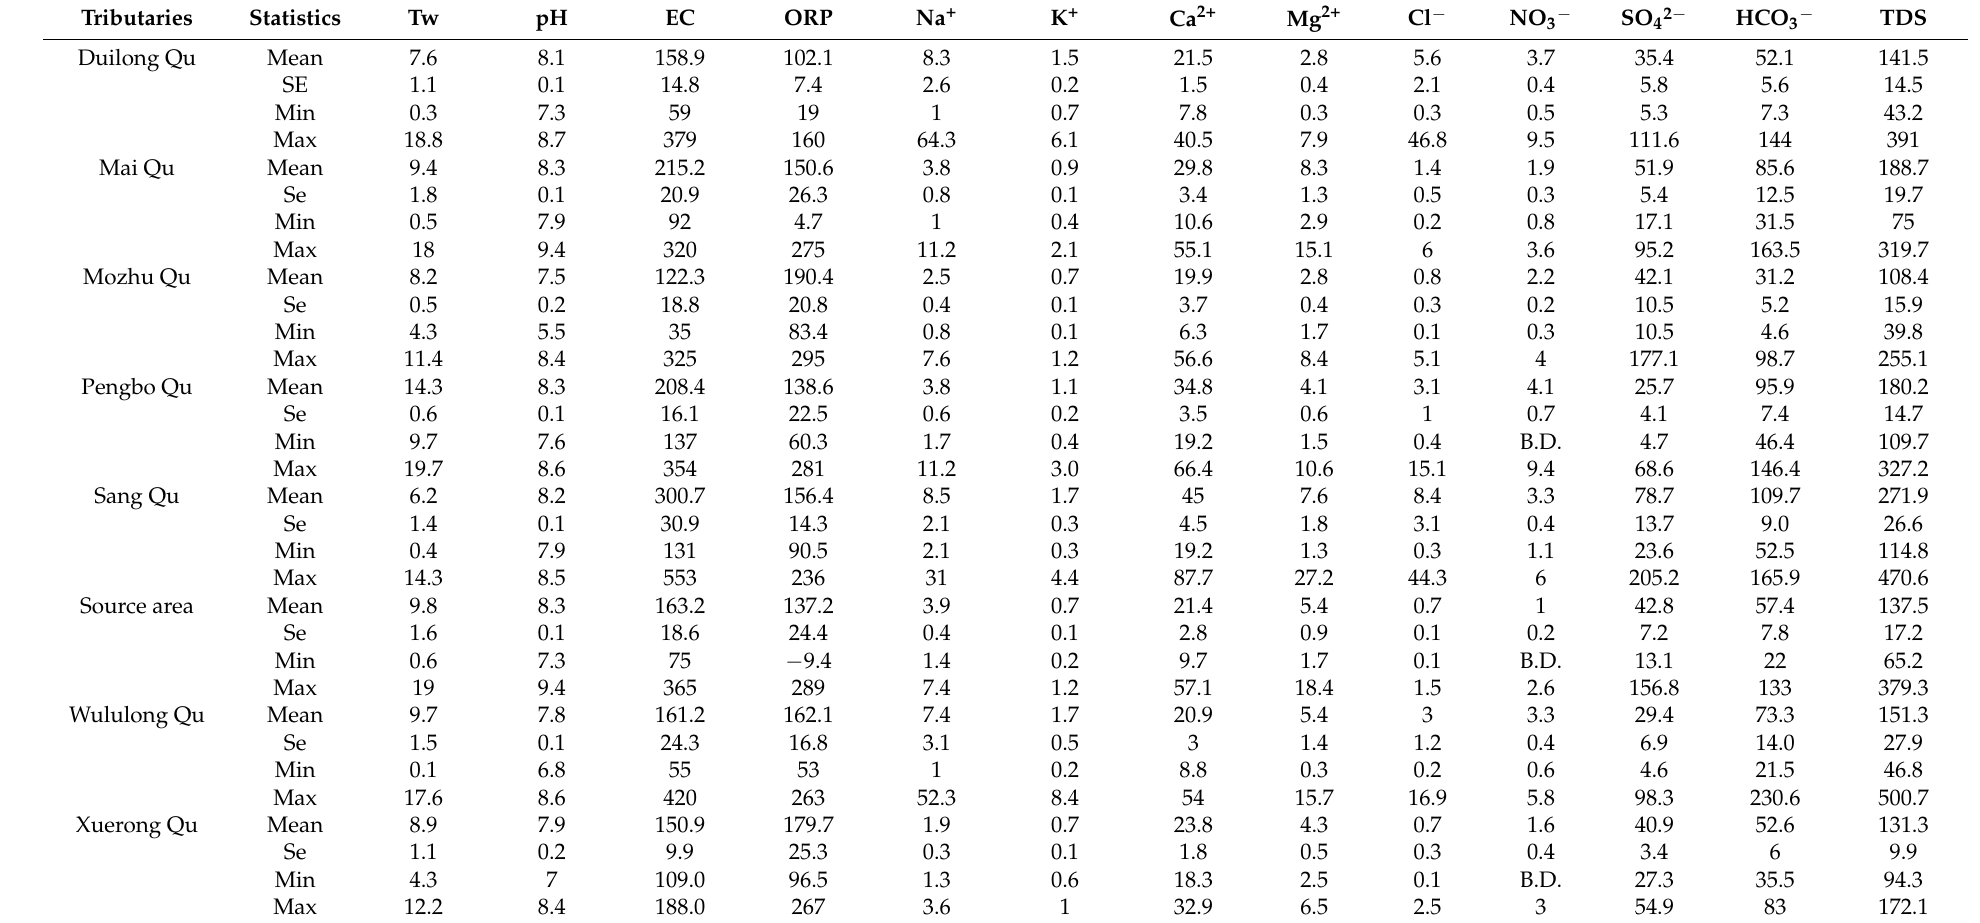
Table 2. Arithmetic means standard error (Se), minimum and maximum values of water chemistry values of the LR major tributaries.